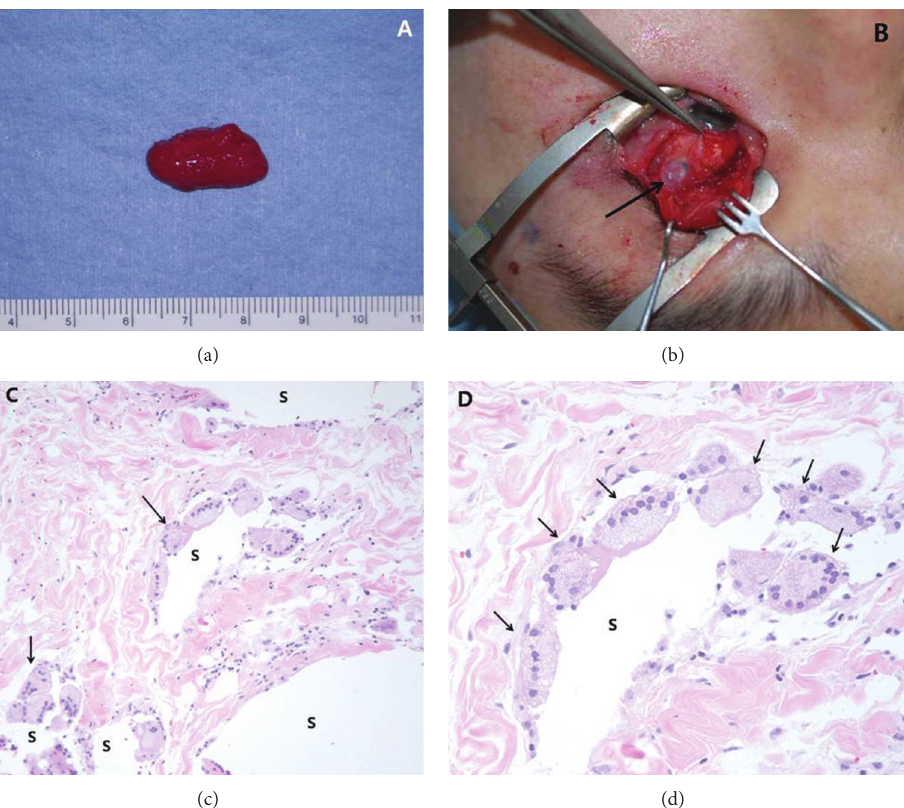
Figure 3: Excision of silicone oil granuloma and histopathology of excised mass. (a) Removed mass which was caused by silicone oil leakage. (b) Melting focus located at 1 o’clock around equator of eyeball which was already healed. Brownish uveal tissue (arrow). (c), (d) Multiple small and large lipid droplets which are silicone oil material (s) surrounded by foreign body giant cells (arrows) with less prominent fibrosis (Hematoxylin and Eosin stain, × 200 and × 400,